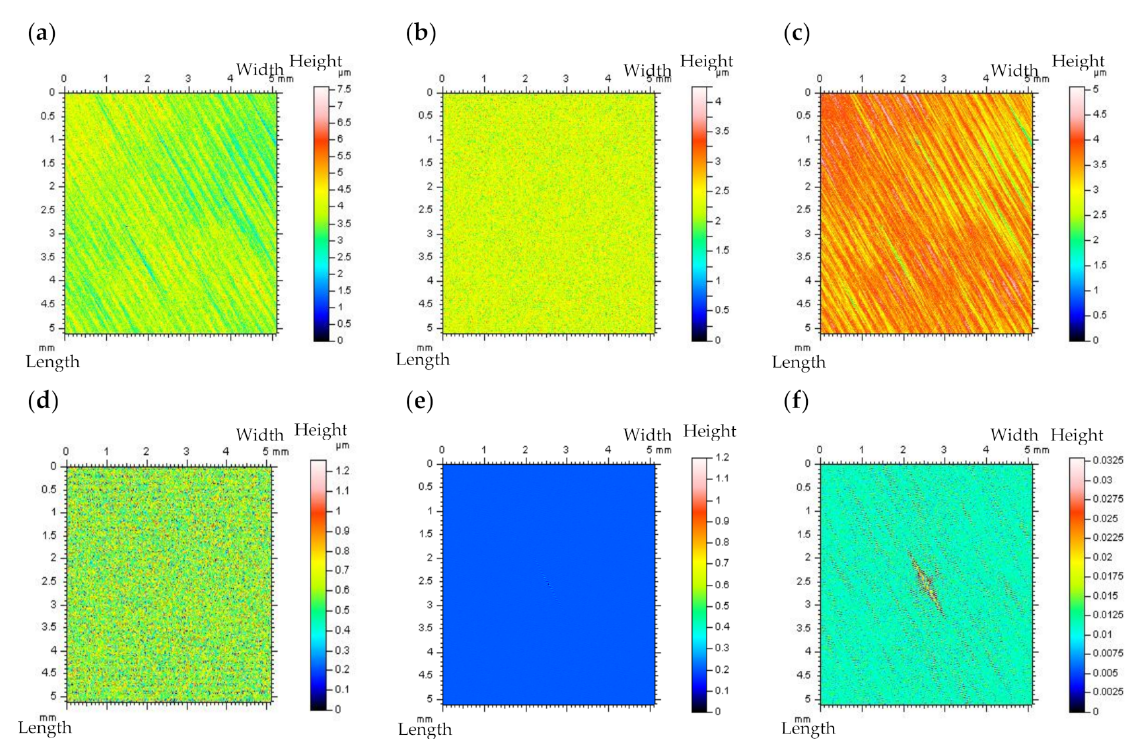
Figure 9. Ground detail measured by a stylus instrument at the speed of 1 mm/s ( a ), and its NS defined by FFTF (cut–off = 0.025 mm) ( b ) with the texture after the HFN denoising ( c ), thresholded (0.13–99.87%) NS ( d ), ACF of NS ( e ) and thresholded ACF of NS received by the FFTF method ( f ); all figures are presented in contour map